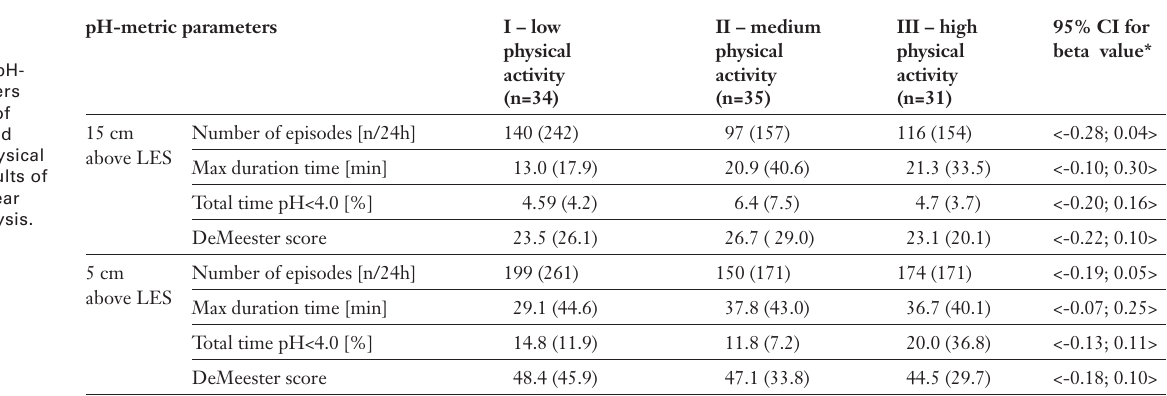
Comparison of pH- metric parameters among groups of low, medium and high level of physical activity and results of multivariate linear regression analysis.